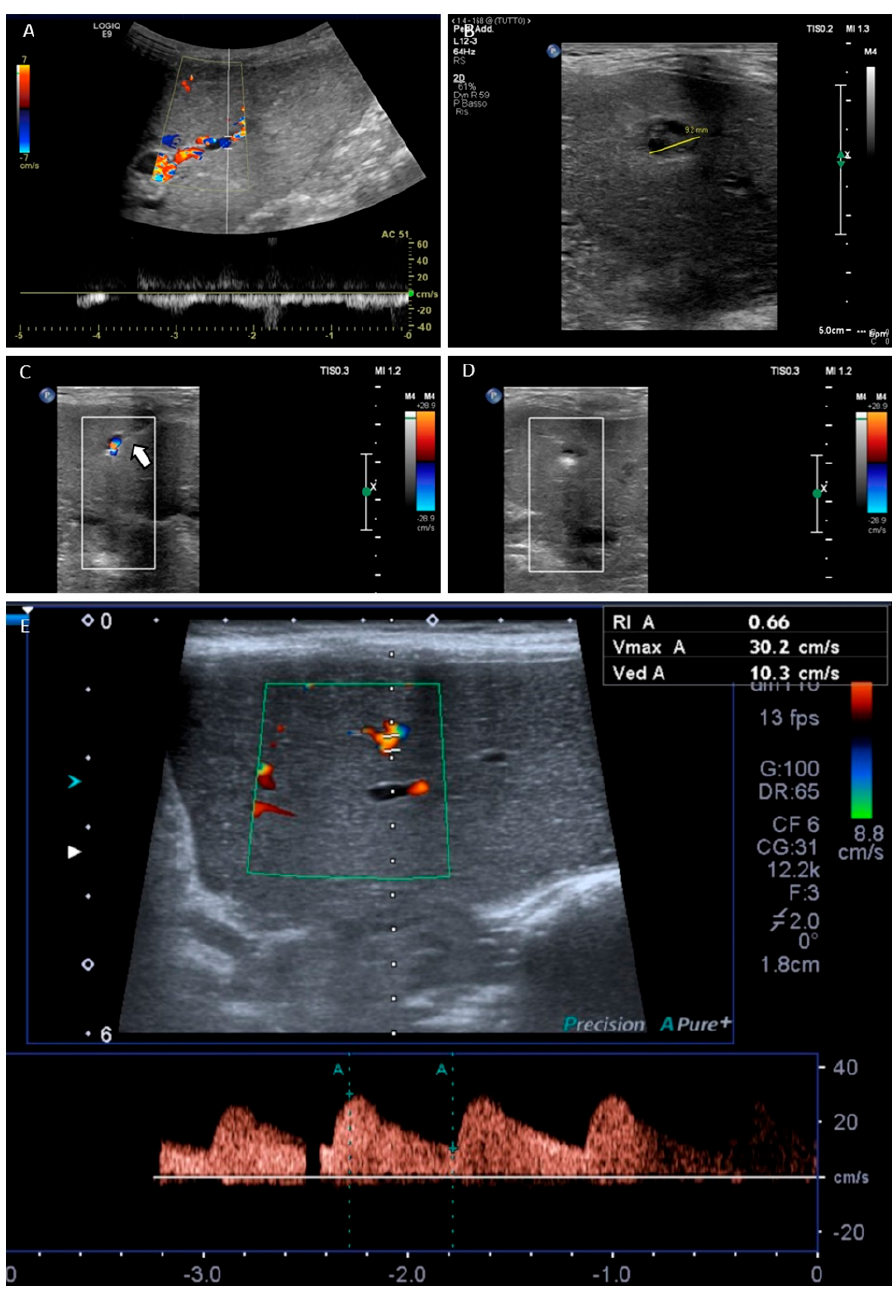
Figure 2. Transhepatic approach: iatrogenic post-biopsy type 1 arterioportal fistula (APF) treated with direct transhepatic hemostatic matrix injection under ultrasound guidance in a 3-year-old child with left lateral segment orthotopic liver transplantation. ( A ) Color Doppler ultrasound (CDUS) diagnosis of hemodynamically significant APF with flow reversal in the segmental portal branch. ( B ) Ultrasound visibility of a 9 mm APF. ( C ) Targeting of the APF with a 20 G Chiba needle (arrow) under CDUS guidance. ( D ) Absence of vascular signals in the APF which is thrombosed after hemostatic matrix injection. ( E ) CDUS follow-up shows disappearance of the APF with normal resistive index (0.66) in the segmental artery.